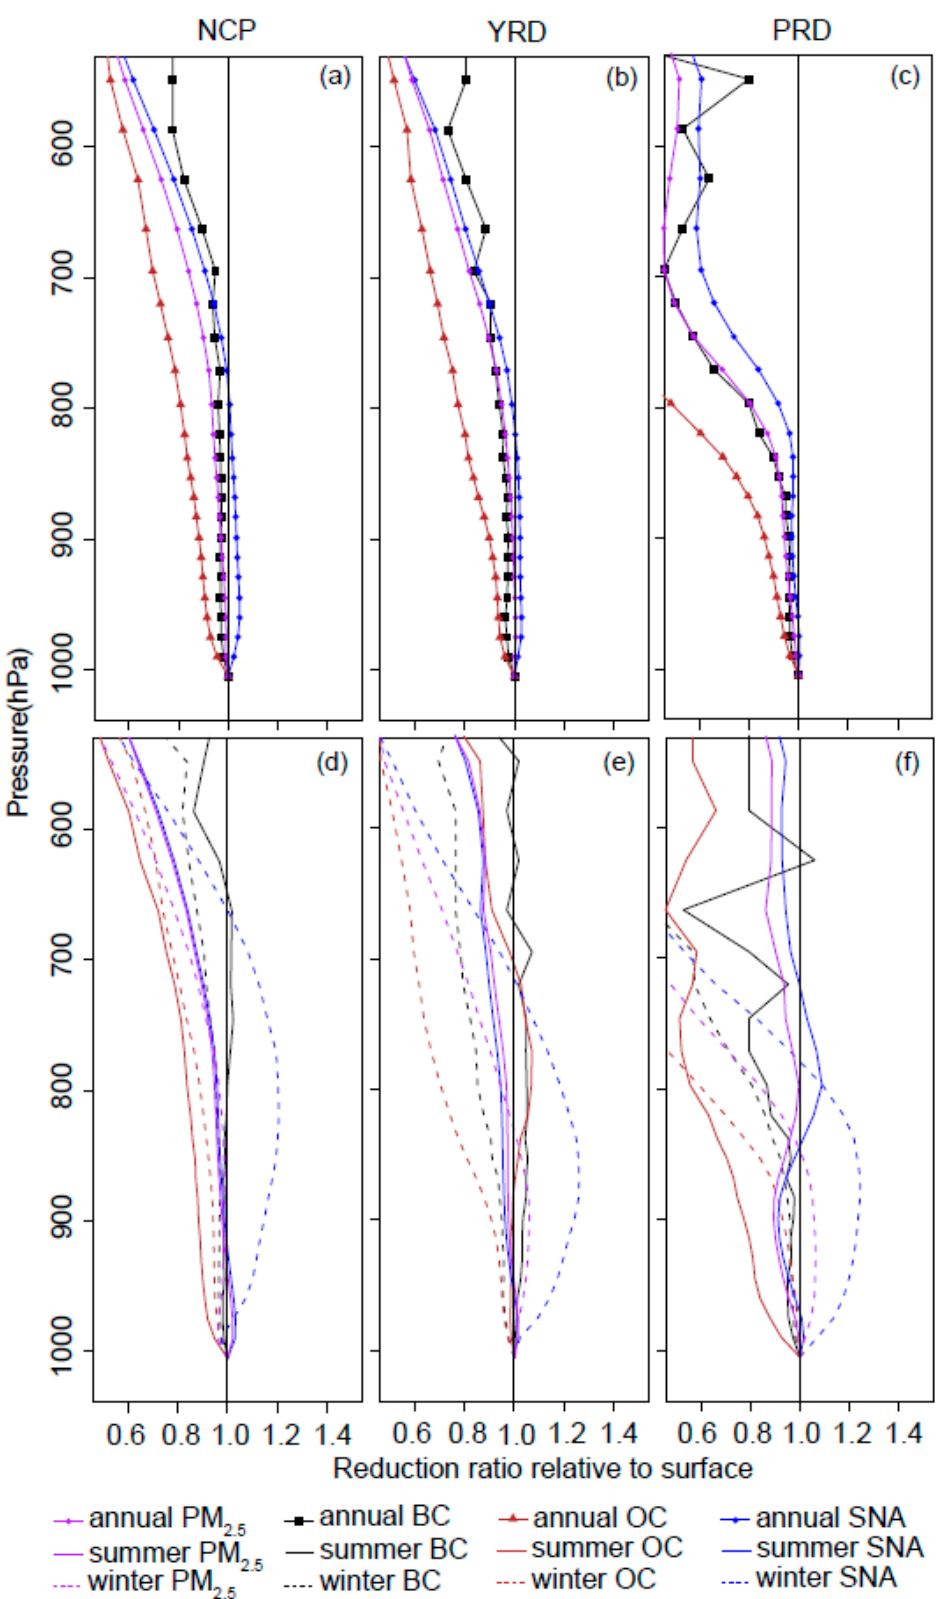
Figure 6. Reduction ratio of PM 2.5 ((PM 2.5_2017 -PM 2.5_2006 )/PM 2.5_2006 , purple) and its components (BC: black lines; OC: brown lines; SNA: blue lines) relative to the surface in 2006 – 2017 for annual mean ( a – c ) and for summer and winter ( d – f ) in NCP, YRD and PRD.